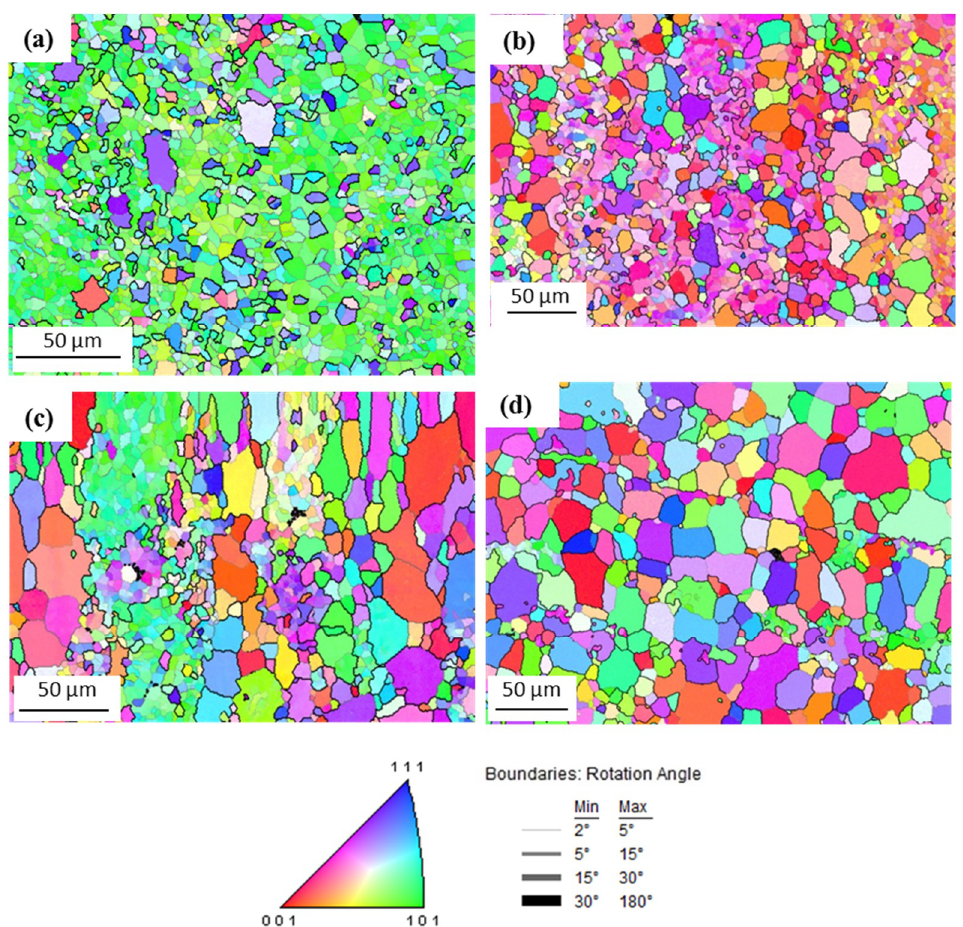
Figure 7. Micro-textures of the experimental alloys annealed under different annealing temperatures for 1 h. Ce-containing alloy: ( a ) 450 °C, ( b ) 520 °C; Ce-free alloy; ( c ) 450 °C, ( d ) 520 °C. The color of each grain was coded by its crystal orientation based on [001] inverse pole figure.